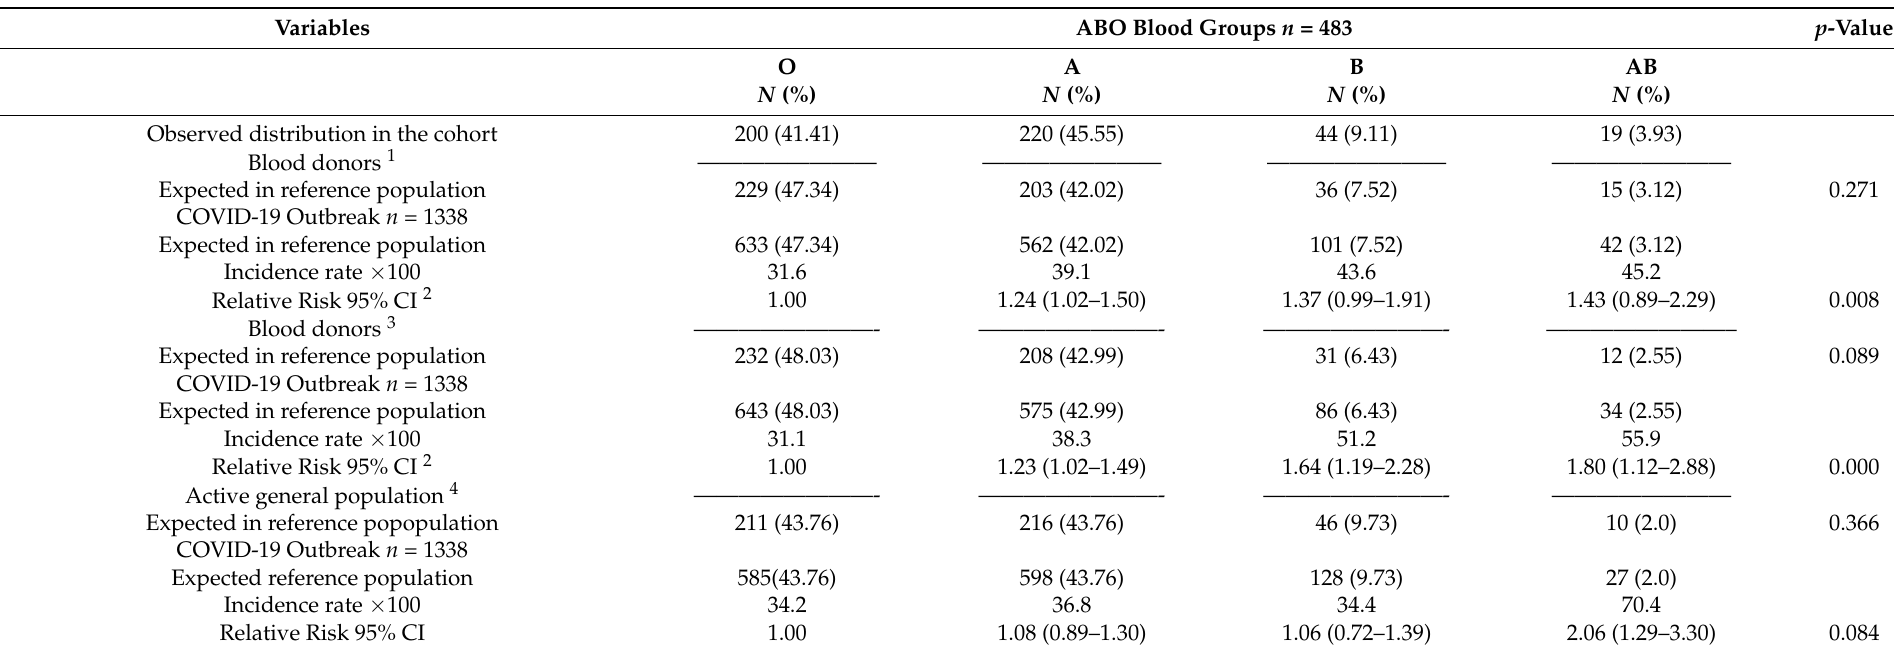
Table 2. Observed distribution of COVID-19 cases of ABO blood groups, incident rate, and relative risk comparing with blood donors, and an active general population from the Spanish Mediterranean zone as the reference population. Borriana COVID-19 cohort